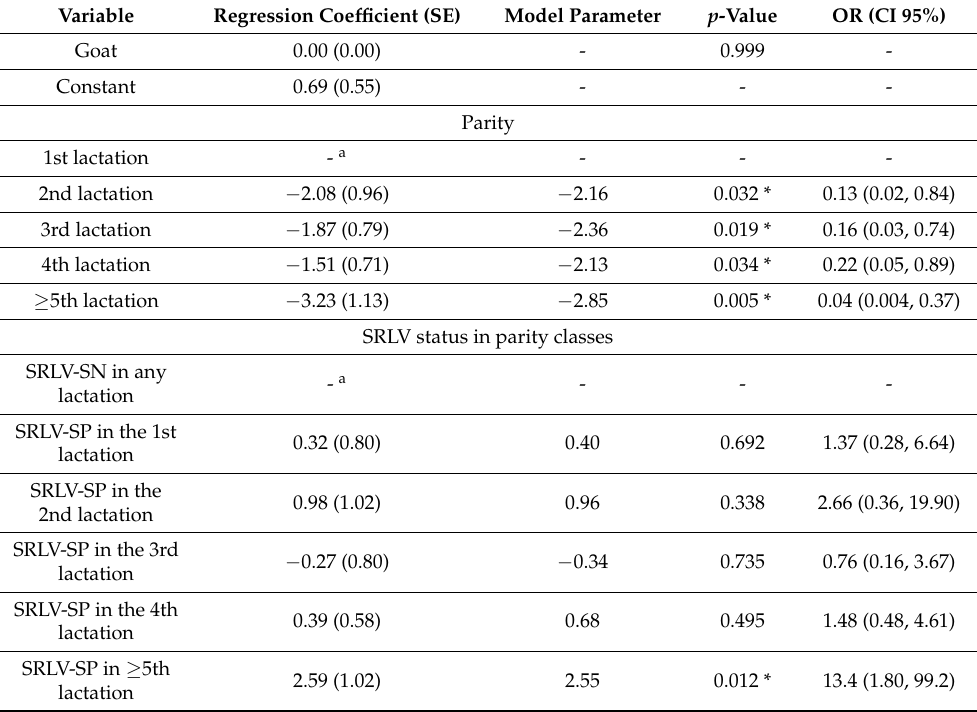
Figure 1. Prevalence of bacteria in milk samples from subsequent lactations, regardless of small ruminant lentivirus infection status. The asterisk (*) indicates statistical significance at α = 0.05. Table 3. The generalized binary logistic mixed model evaluating the influence of SRLV infection on the prevalence of bacteria in milk samples controlled for possible confounders.